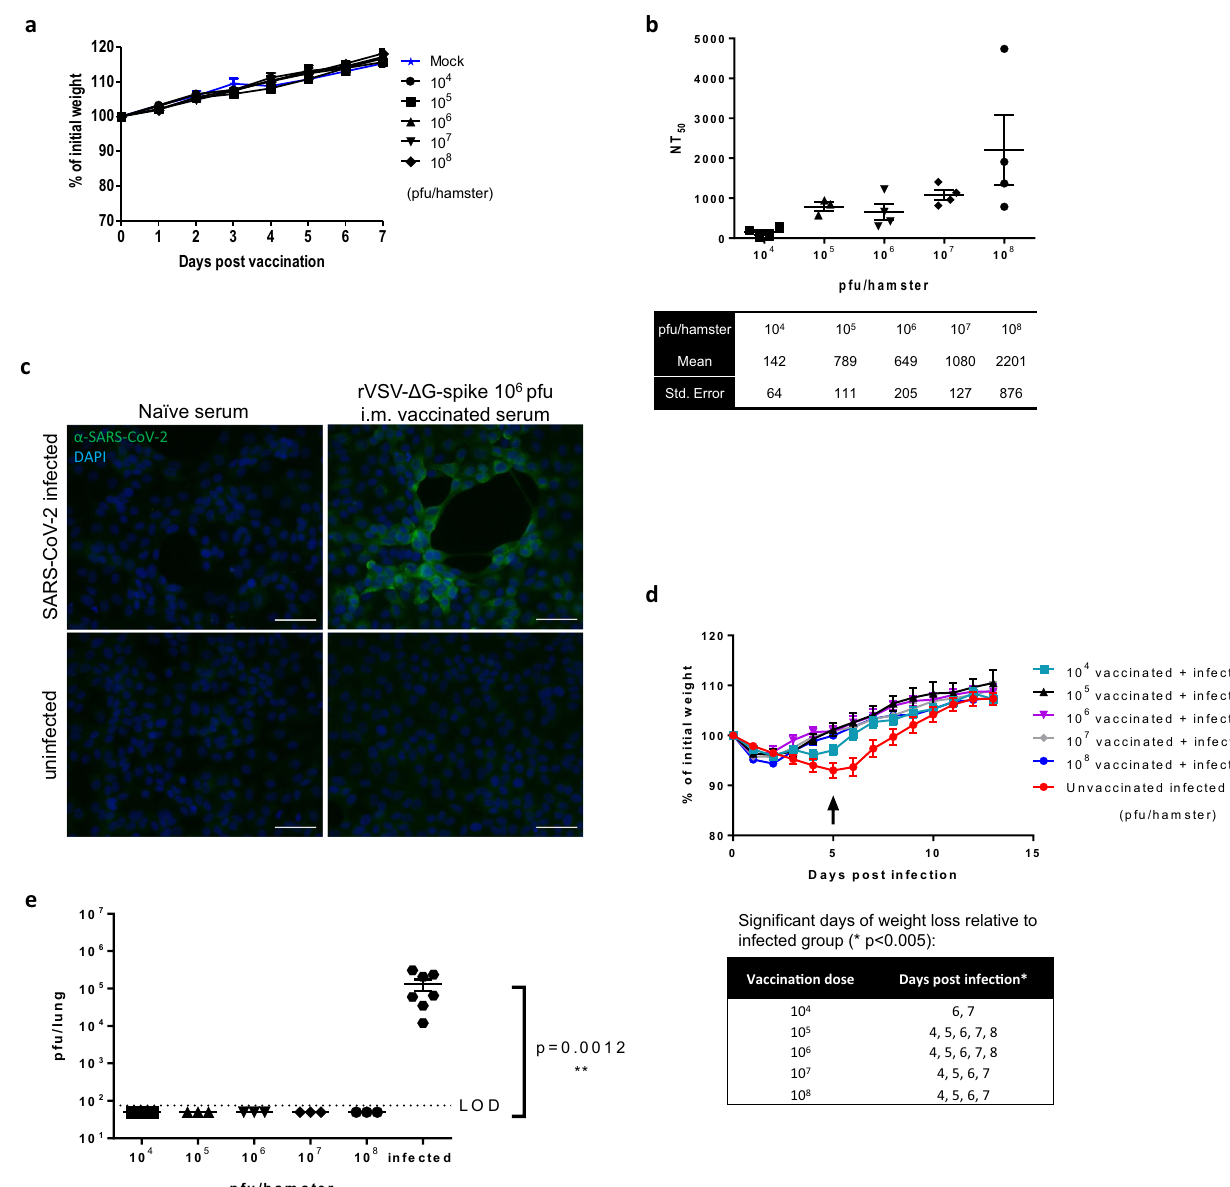
Fig. 5 A single-dose i.m. rVSV- Δ G-spike vaccine safety and ef fi cacy in hamsters following SARS-CoV-2 challenge. a Body weight changes of mock- vaccinated hamsters ( n = 4), and hamsters vaccinated with rVSV- Δ G-spike ranging from 10 4 to 10 8 pfu/hamster ( n = 10, n = 11, n = 11, n = 11, n = 10, for each vaccinated group, respectively). b NT 50 values of i.m. vaccinated hamsters ’ sera (10 4 – 10 8 pfu/hamster) against SARS-CoV-2 ( n = 4 for 10 4 , 10 6 , 10 7 , and 10 8 , n = 3 for 10 5 ). Means and SEM are indicated below the graph. c Representative immuno fl uorescence images of Vero